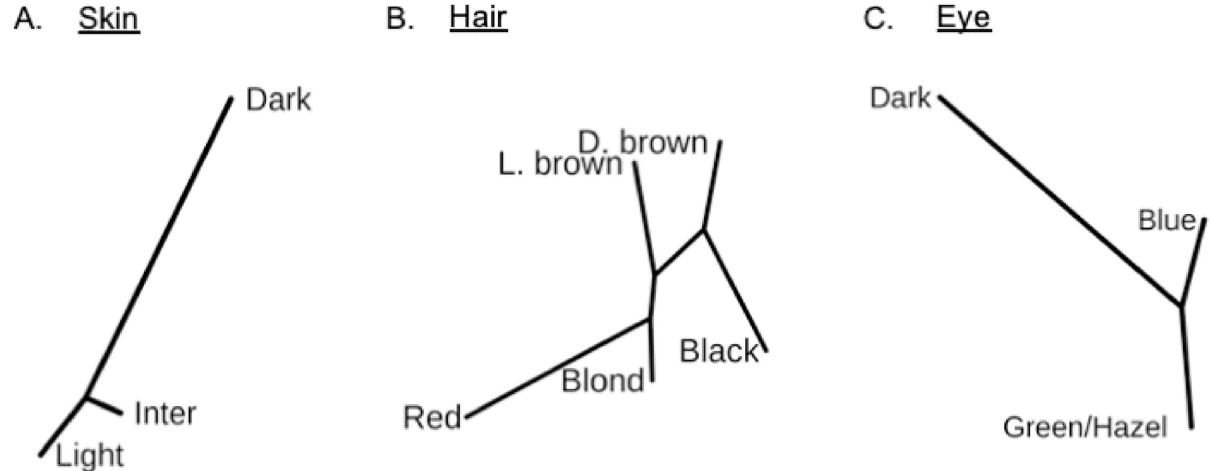
Fig 1. Color phenotype profile based on MC1R variation in an admixed population. Phylogenetic tree based on neighbor-joining method using the F st distance of different groups of ( A ) skin, ( B ) hair and ( C ) eye colors.